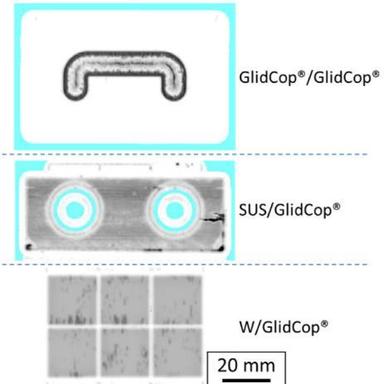
UT images of the joint interface of GlidCop®/GlidCop®, SUS/GlidCop® and W/ GlidCop® in the first AMSB divertor mork-up of Fig. 9. The bright white area means that there are no joint defects in GlidCop®/GlidCop® joint. The gray area means that there are no joint defects in SUS/GlidCop® and W/GlidCop® joint.